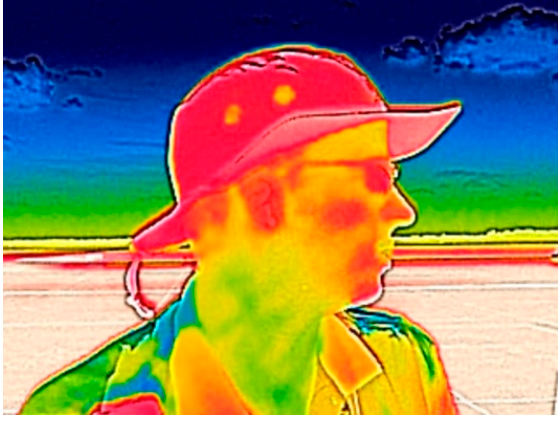
Figure 1. Example of thermal image of a participant’s face profile.